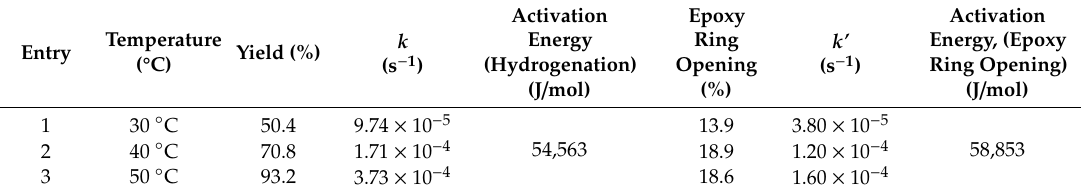
Table 3. Calculated pseudo first order rate constants and activation energies for the hydrogenation of BE503 and epoxy ring opening using Rh 5 / VulcanXC72-polyol.